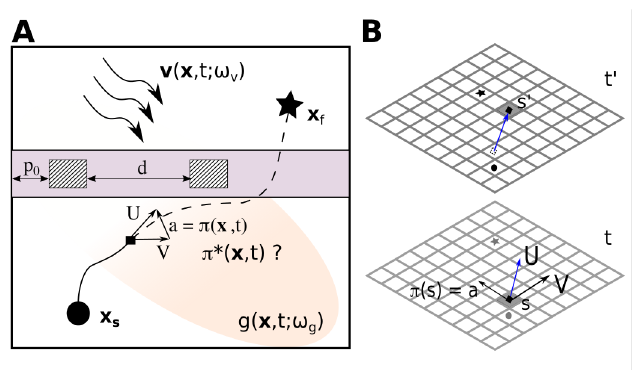
Figure 1. Schematic of the problem statement in continuous and discrete settings: ( A ) The au- tonomous agent’s mission is to travel from x s to x f in a domain under the influence of a stochastic dynamic flow field v ( x , t ; ω v ) and a stochastic dynamic scalar field g ( x , t ; ω g ) that must be collected. We seek a set of optimal policies π ∗ ( x , t ) that optimizes a multi-objective cost function. ( B ) In the discretized spatio-temporal grid, the agent takes an action a = π ( s ) from state s at discrete time t to reach s (cid:48) in the next time-step t (cid:48) under the influence of random discrete velocity V ( s )